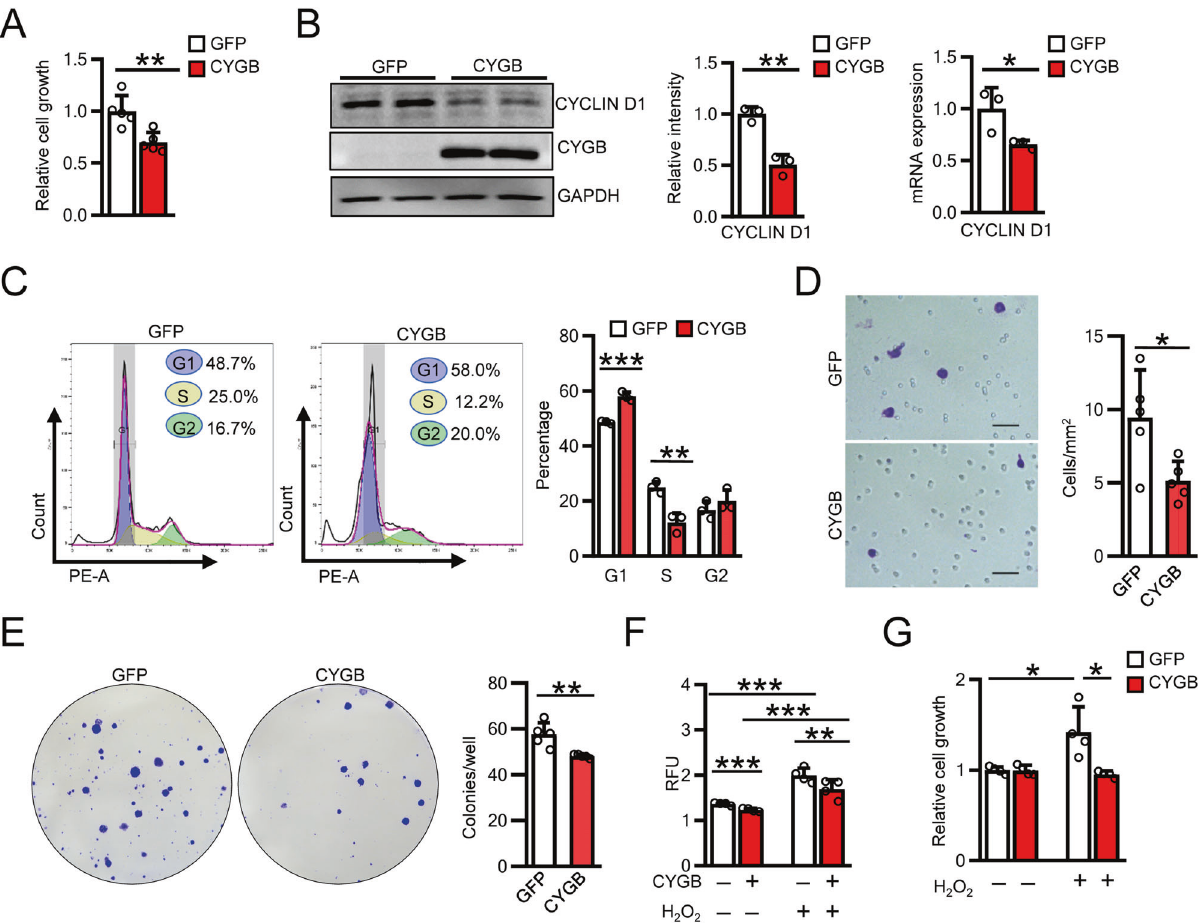
Fig. 6 Overexpression of CYGB suppressed human pancreatic cancer cell proliferation. A , B Determination of MIA PaCa-2 cell proliferation by CCK-8 assay ( A ). The cells were stably transfected with lentiviral eGFP expression vector (GFP) or CYGB expression vector (CYGB), n = 5. Cell lysates were collected for immunoblotting (left and middle panels) and qRT-PCR analysis (right panel) for Cyclin D1, n = 3 ( B ). GAPDH was used as loading control. C Flow cytometric determination of cell cycle distribution in MIA PaCa-2 transfected with lentiviral eGFP expression vector (GFP) or CYGB expression vector (CYGB), n = 3. D , E Determination of cell migration for 24 h ( D ) and colony formation for 12 days ( E ) in MIA PaCa-2 transfected with lentiviral eGFP expression vector (GFP) or CYGB expression vector (CYGB), n = 3. Scale bars, 50 µm. F Determination of intracellular ROS by DCFDA assay using H 2 O 2 500 µM administration for 1 h in MIA PaCa-2 which were 48 h transiently transfected with empty vector (CYGB − ) or pcDNA-6His-FLAG-CYGB vector (CYGB + ), n = 4. G Determination of cell proliferation by CCK-8 assay in MIA PaCa-2 transfected with lentiviral eGFP expression vector (GFP) or CYGB expression vector (CYGB) under H 2 O 2 40 µM for 4 h, n = 4. Data were shown as mean ± SD from three independent experiments. * p < 0.05, ** p < 0.01, *** p < 0.001, Student ’ s t test, two-tailed. RFU relative fl uorescent